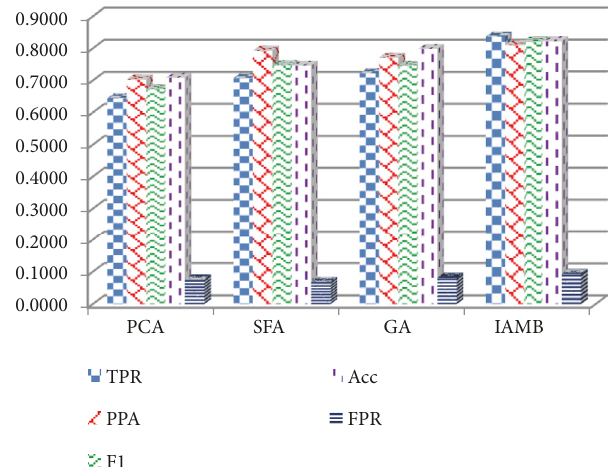
Figure 7: The effectiveness comparison between IAMB and the other three